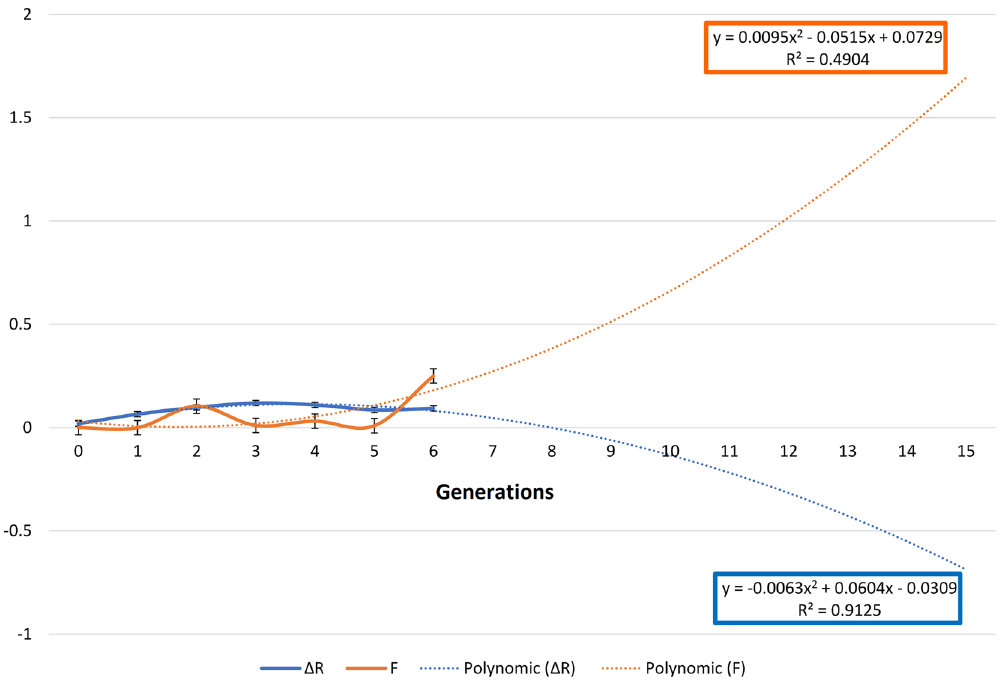
Figure 4. Regression equations for average inbreeding ( F ) and average relatedness (Δ R ) expressed in % from 1ª to 6ª generation, and their prediction from 7ª to 15ª generation. Provided we measured the variability of time- series data, we relied on the standard error of the mean (SEM) rather than the standard deviation (SD), as it removes variability imposed by the trend in the data, which the SD does not.